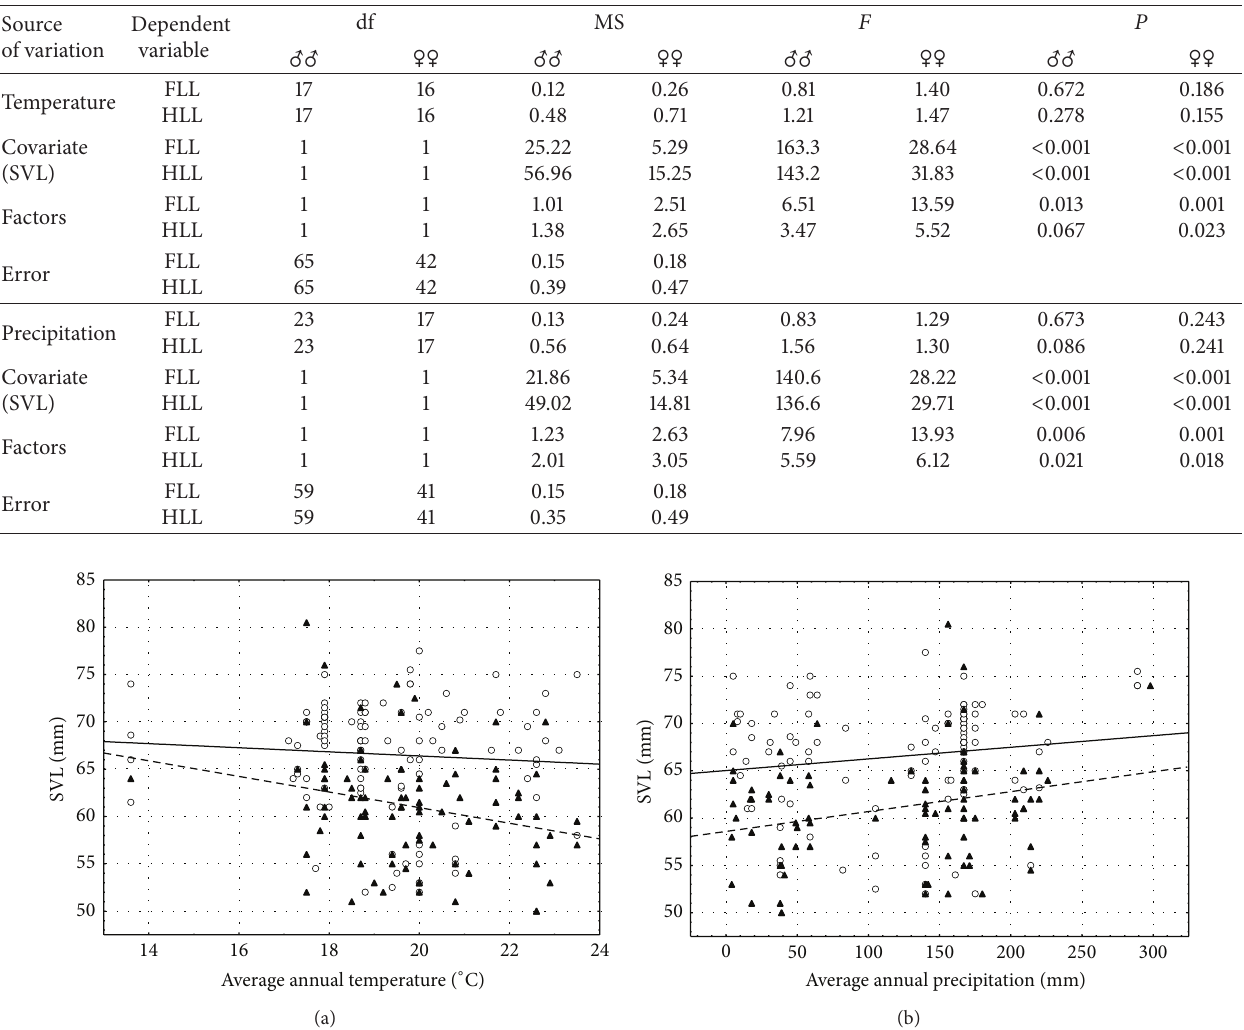
Table 5: Results of a MANCOVA examining the effect of temperature and precipitation on total fore limb length (FLL) and total hind limb length (HLL) in Ophisops elegans with SVL as a covariate.